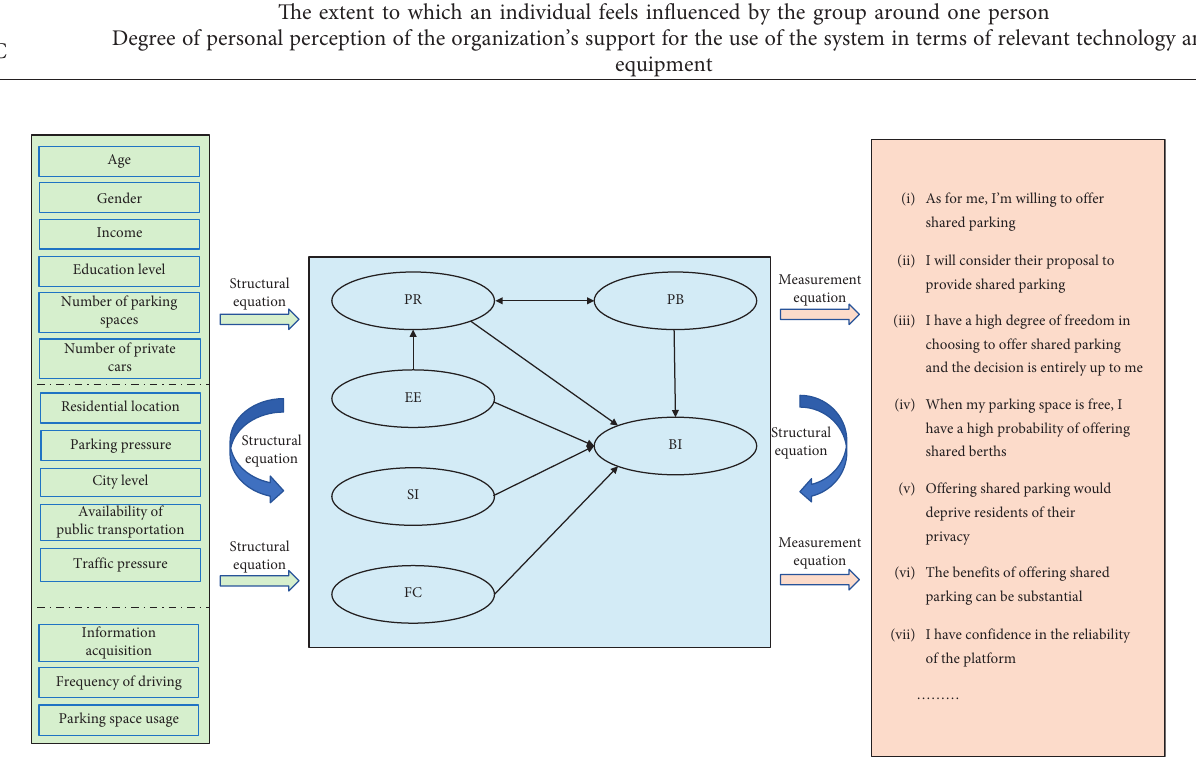
Figure 1: Structure framework of the MIMIC model of shared intention.